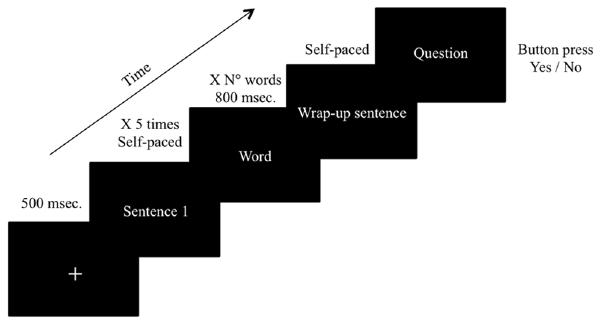
Figure 1. Experimental procedure. doi:10.1371/journal.pone.0066839.g001 PLOS ONE |